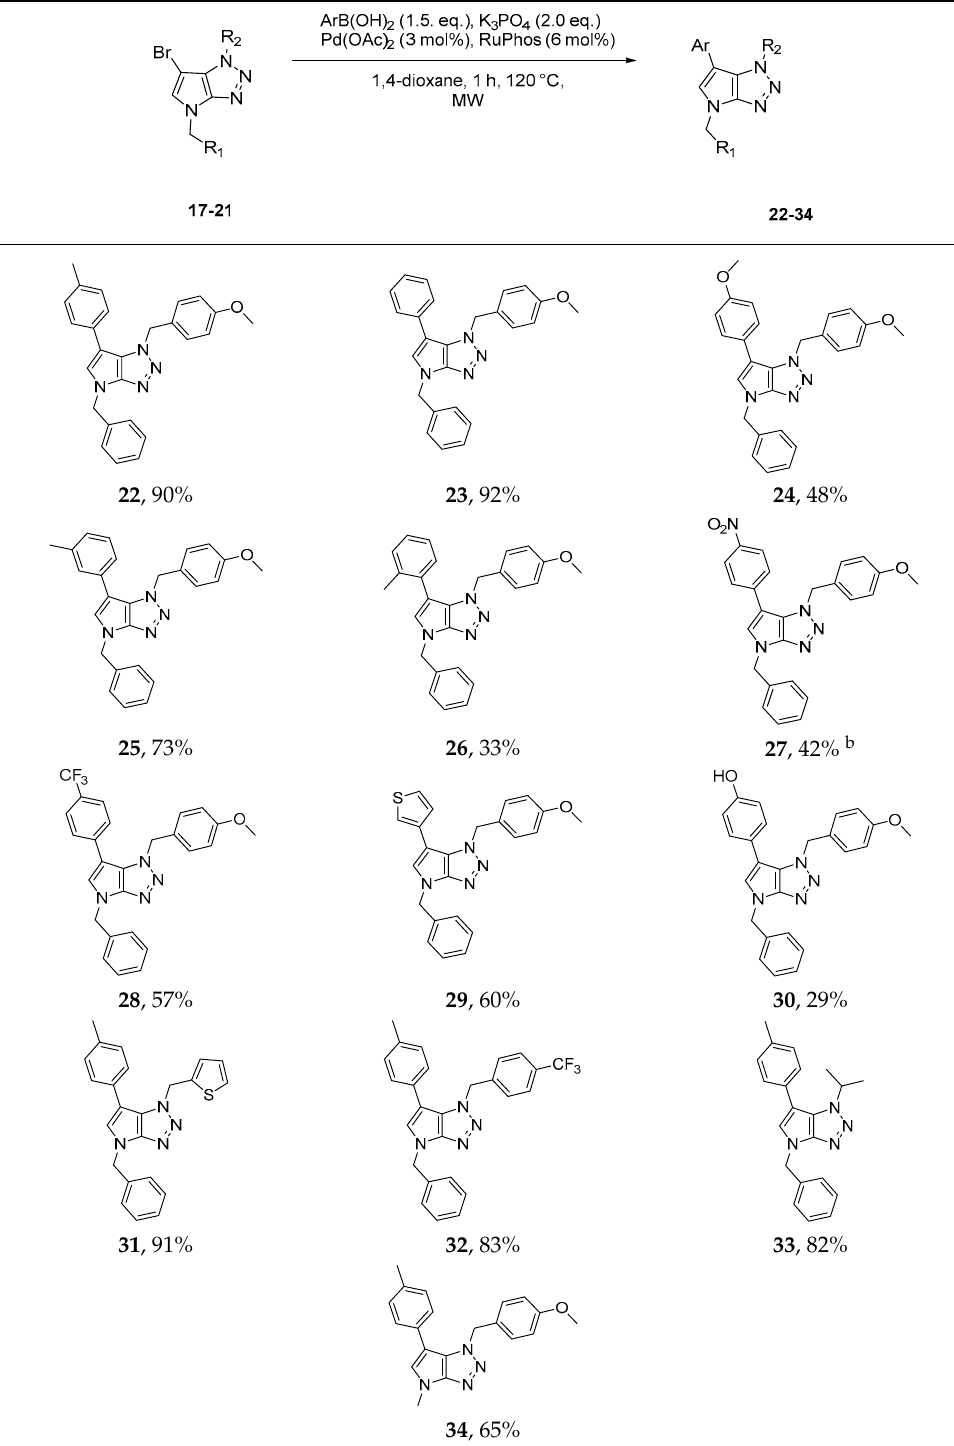
Table 5. Scope of the Suzuki-Miyaura reaction in C-6 position: synthesis of 22 – 34 a .